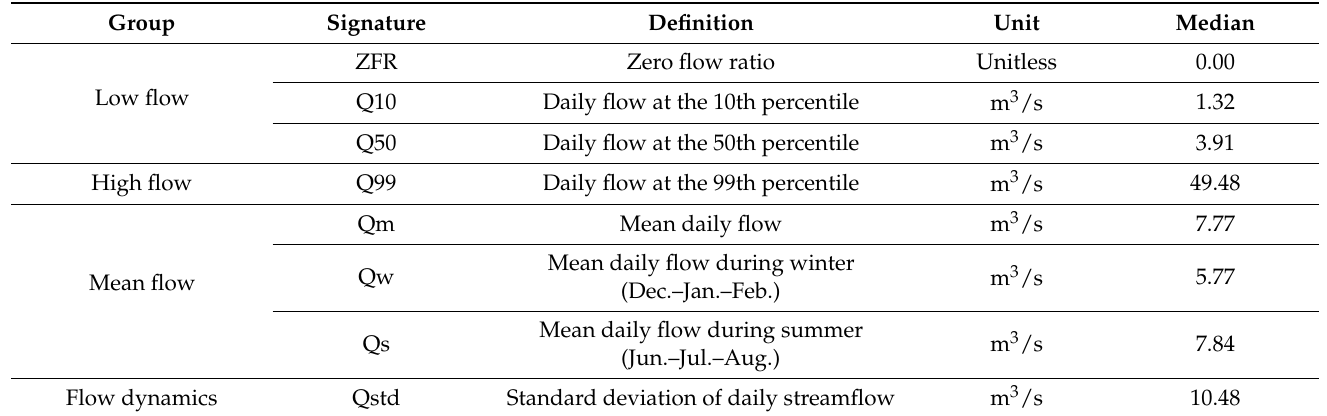
Table 1. Summary of eight runoff signatures in the 10,044